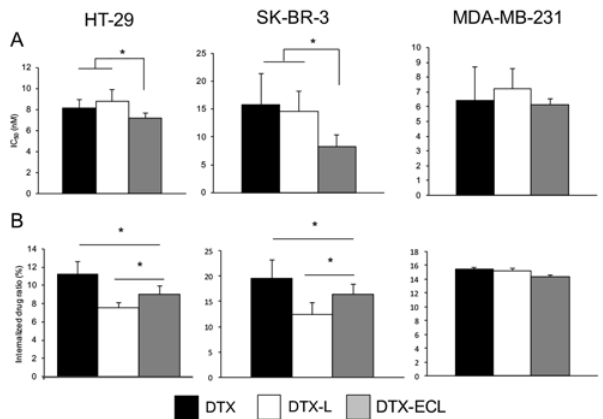
Figure 4. Cytotoxicity and internalized drug amount in HER2 positive cancer cells (HT-29 and SK-BR-3) and HER2 negative cancer cells (MDA-MB-231) treated with DTX-ECL. The cytotoxicity of DTX-ECL after 3-hour drug exposure was evaluated by the MTT assay ( A ). The internalized drug amounts after 3-hour drug exposure were determined by reverse-phase HPLC ( B ). * P < 0.05; N = 4.